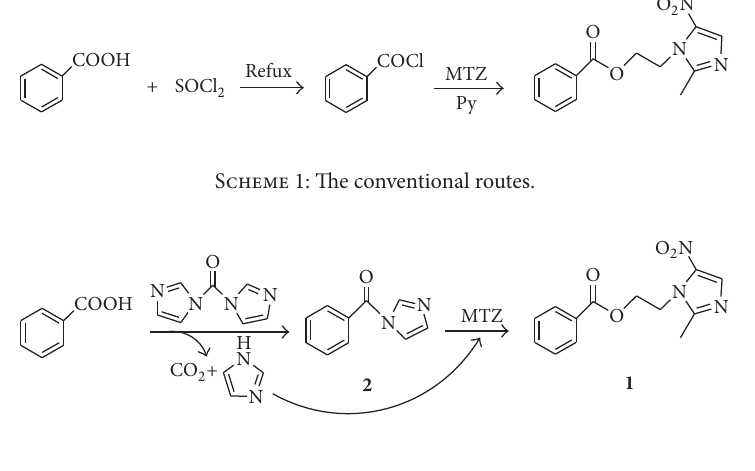
S 2: e improved convenient